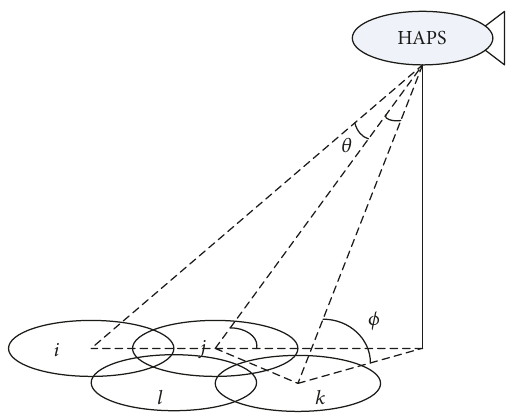
Figure 3: The communication network structure of